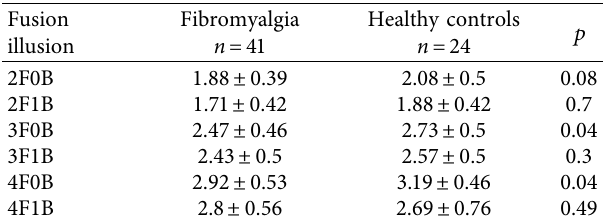
Table 5: Comparison of the fusion illusion conditions in patients with fibromyalgia and healthy controls. Data are plotted in the Figure 1(d).